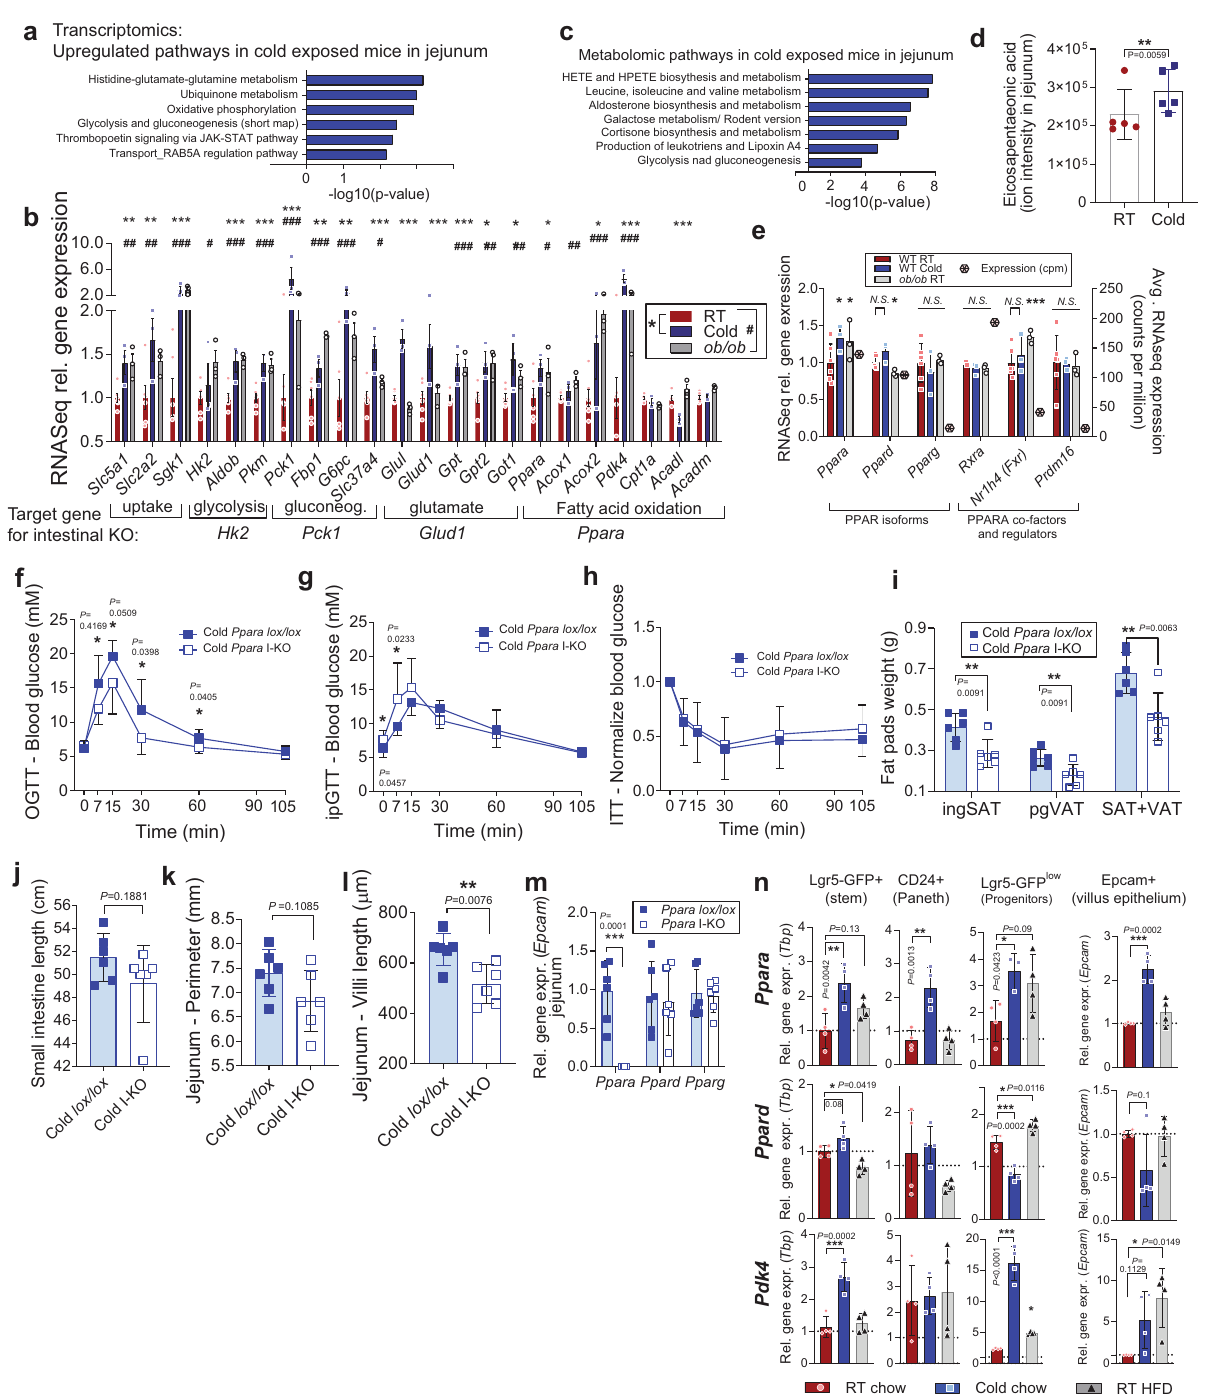
Intestinal Ppara KO reduces fat absorption and accumulation during HFD . To investigate the functional role of intestinal PPAR α in caloric absorption, we fed C57BL/6 J HFD (60% of calories from fat) or HF-HS diet (60% of calories from fat, 25% from sucrose) for six weeks. Both diets robustly increased expression of Ppara in the jejunum, together with its target genes Acox1 and Pdk4 (Fig. 3a). Ppara I -KO gained less body weight when put on HFD (Fig. 3b), despite the same food intake as controls (Fig. 3c). As energy expenditure did not differ between the controls and Ppara I-KO (Supplementary Fig. 8a, b), we measured ef fi ciency of caloric absorption by